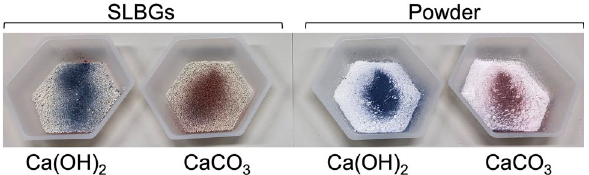
Figure 5. Detection of carbonation of Ca(OH) 2 using a pH indicator. SLBGs containing Ca(OH) 2 or CaCO 3 (left) or powder consisting of Ca(OH) 2 or CaCO 3 (left) (right) were sprayed with the pH indicator we developed (Uwai et al., manuscript in preparation). Granules and powder containing Ca(OH) 2 instantly turned blue from red due to their strong alkalinity, but granules and powder containing CaCO 3 remained red (Supplementary Movie